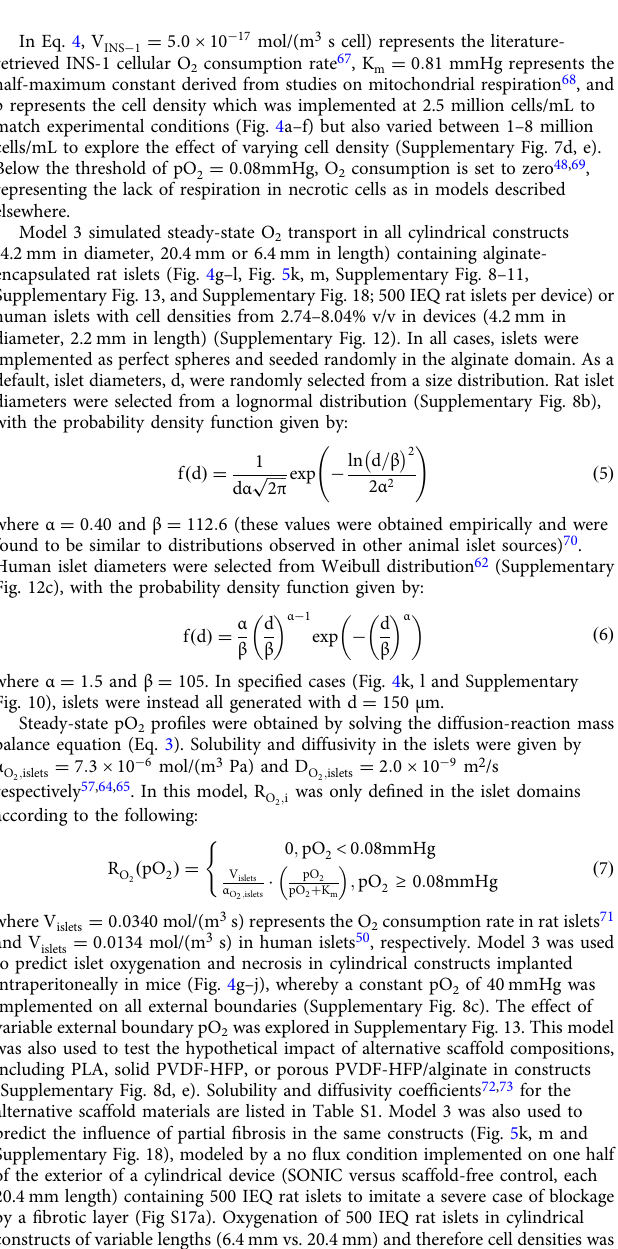
Supplementary Fig. 19): a scaffold-free control device and a SONIC device. A constant pO 2 of 40 mmHg was applied to all exterior boundaries. All